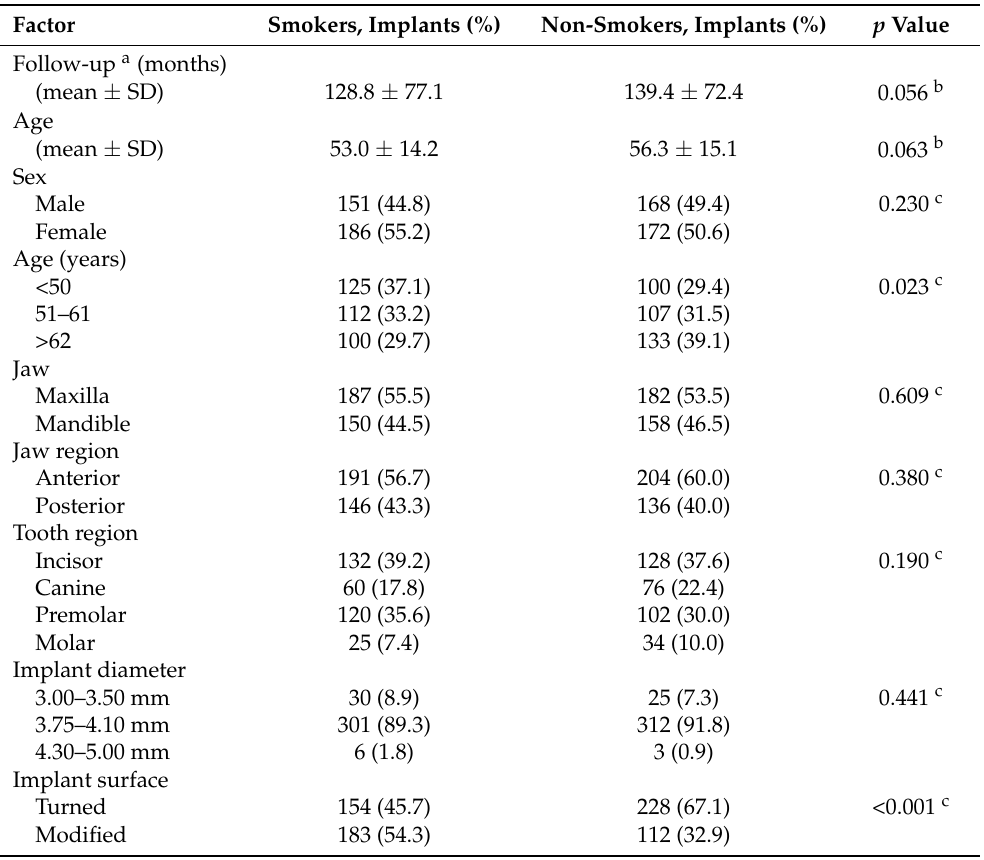
Table 1. Descriptive data of the implants included in the study, separated by group. The statistical unit is the implant, not the